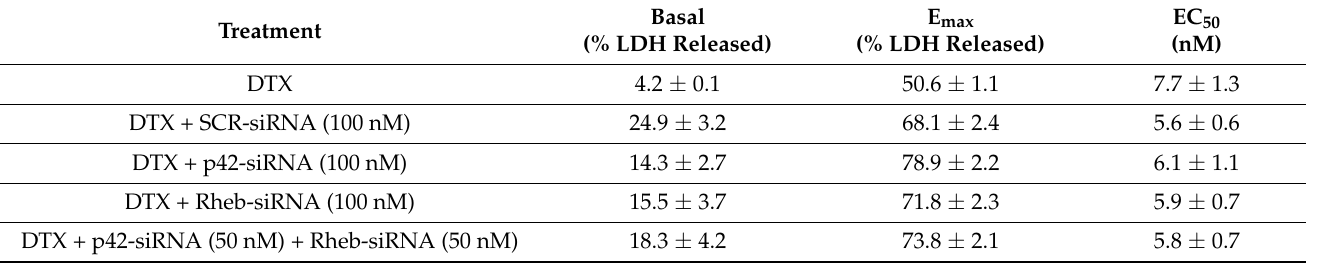
Table 1. DTX-induced toxicity and EC50 values. LNCaP prostate cancer cells were exposed to DTX (0.1 nM to 1 µ M) alone or in the presence of different siRNA treatments for 72 h and toxicity determined. Individual DTX dose–response curves were fitted to a log concentration versus response model. Data represent mean ± SEM of 5 to 12 experiments.